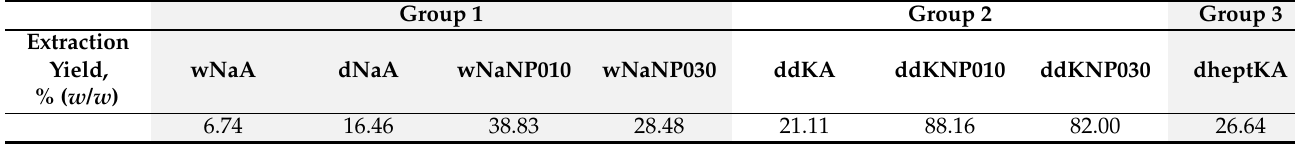
Table 4. Extraction yields of monomeric cutin from tomato peels. Results are given as % (w freeze-dried extract /w dried tomato peels ). Group 1 Alkaline Hydrolysis : wNaA , wet tomato peels, de- polymerization with NaOH, acidification; dNaA , dry tomato peels, depolymerization with NaOH, acidification; wNaNP010 wet tomato peels, depolymerization with NaOH, processed with NP010; wNaNP030 , wet tomato peels, depolymerization with NaOH, processed with NP030. Group 2 Dewaxing (Acetone and Ethanol) and Ethanolic Alkaline Hydrolysis : ddKA , dry tomato peels, dewaxing with acetone and ethanol, de-polymerization with KOH, acidification; ddKNP010 , dry tomato peels, dewaxing with acetone and ethanol, depolymerization with KOH, processed with NP010; ddKNP030 , dry tomato peels, dewaxing with acetone and ethanol, depolymerization with KOH, processed with NP030. Group 3 Dewaxing (Heptane) and Ethanolic Alkaline Hydrolysis